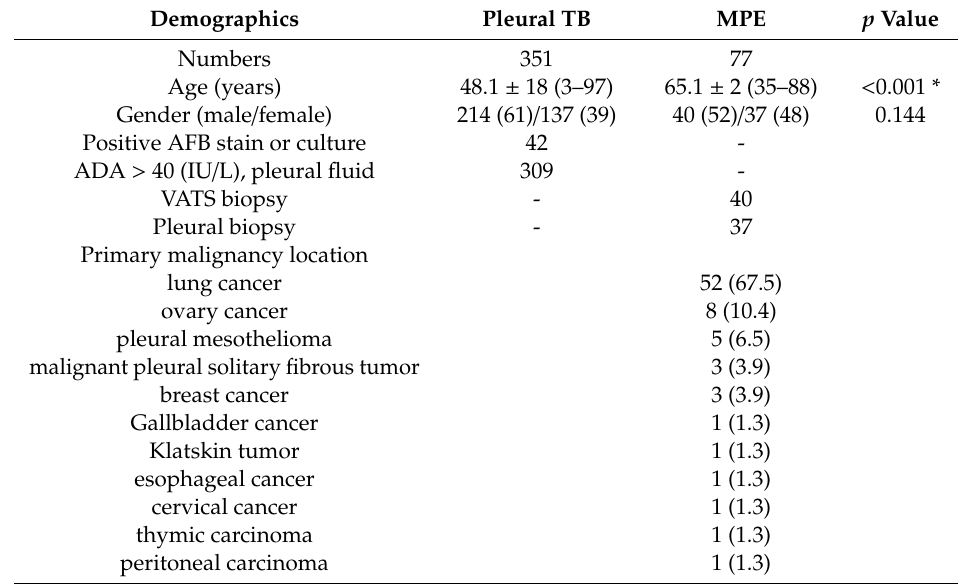
Table 1. Basic characteristics of patients with pleural tuberculosis and those with malignant e ff usion.